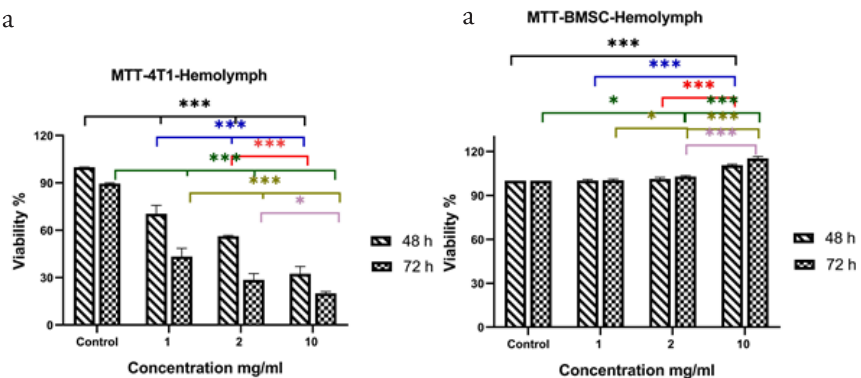
Figure 4. 4T1 (a) and BMSCs (b) Viability (%) in Different Concentration of Crab Hemolymph (MTT Assay). Cell viability in the 4T1 cancer cell line was decreased in a dose- and time-dependent manner. In the BMSCs, cell growth was increased in a dose- and time-dependent manner. There is significant difference between the groups ( P ≤ 0.001***, P ≤ 0.02*). The data is shown as mean ± SD.